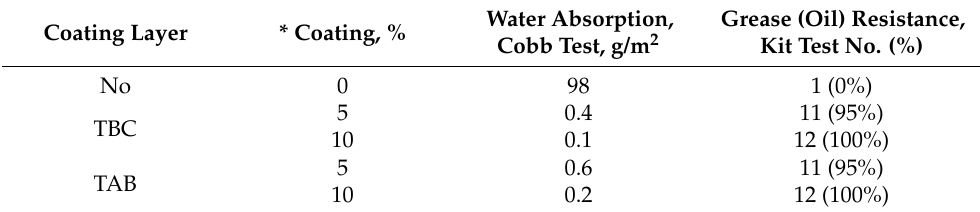
Table 5. Barrier propertied of coating